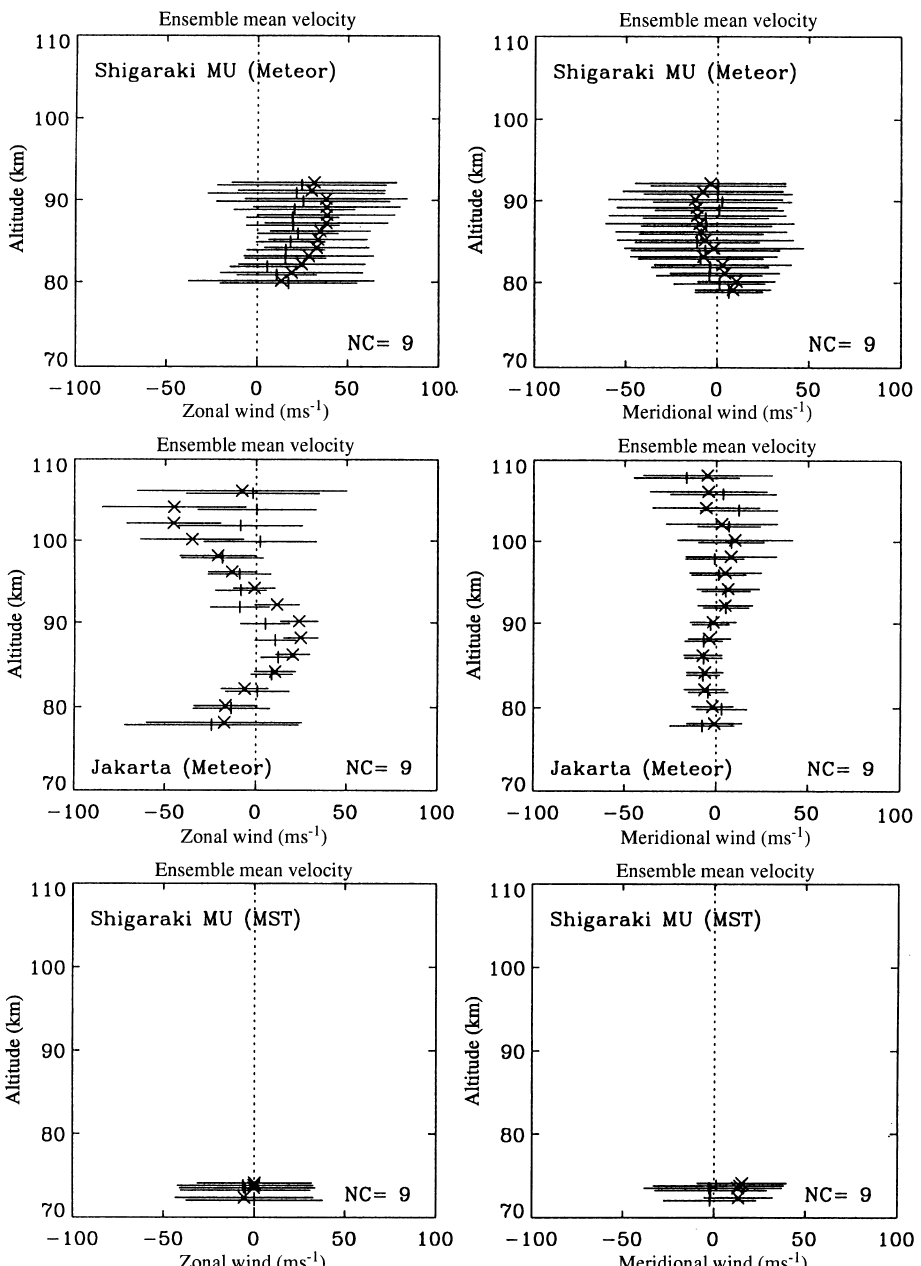
Fig. 4. Vertical profiles of the ensemble mean wind velocity components simultaneously observed by HRDI ( crosses ) and radars ( pluses ). Horizontal bars are the confidence interval of 99% . To avoid overlap of bars, wind profiles are shifted 0.15 km upward for HRDI and 0.15 km downward for radars. Left : zonal wind, right : meri- dional